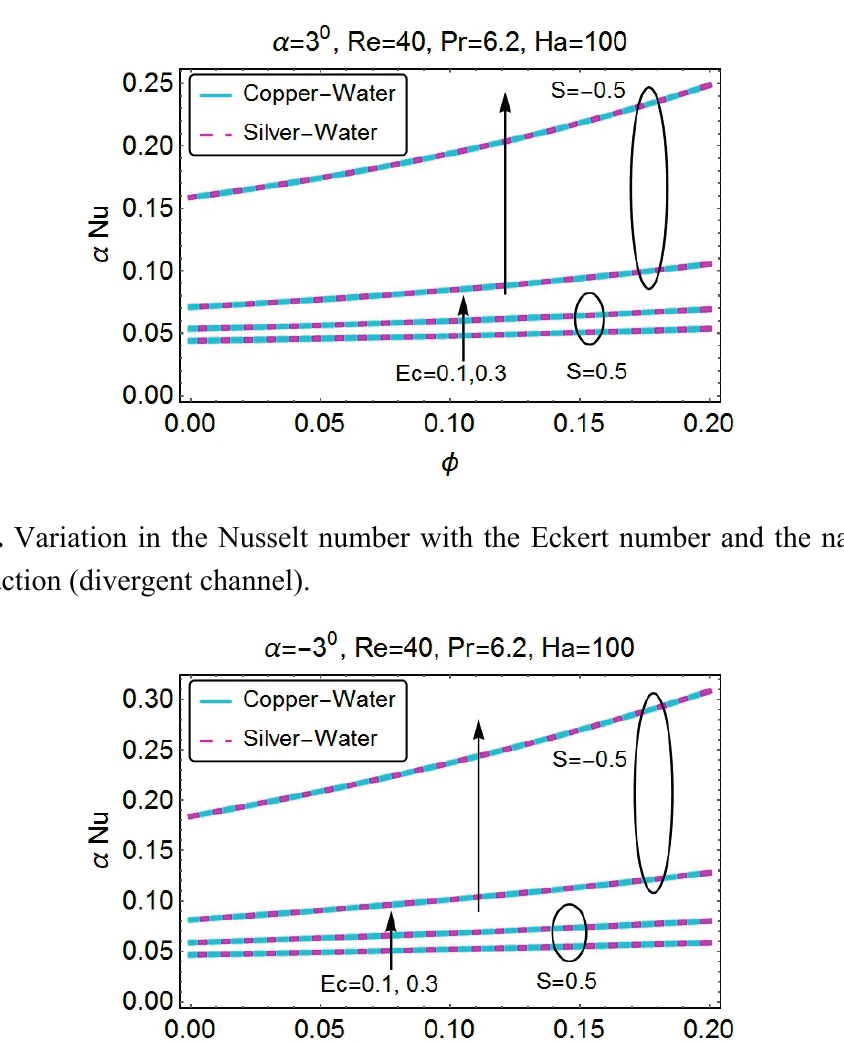
Figure 33. Variation in the Nusselt number with the angle and the nanoparticle volume fraction (convergent channel).